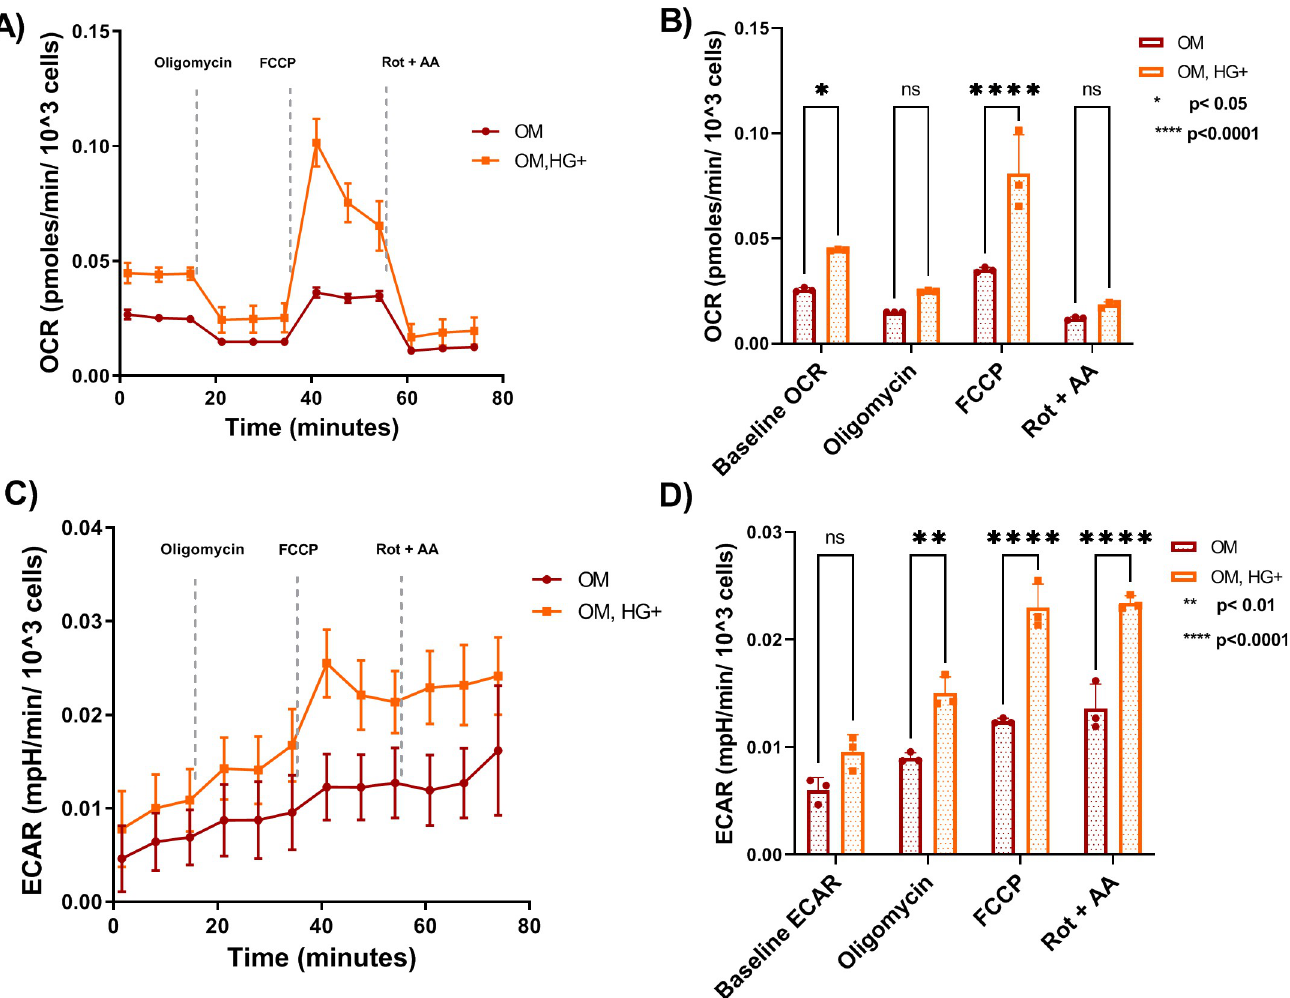
Fig 4. HG-induced osteoblast cells utilize both mitochondrial respiration and Glycolysis more efficiently than healthy cells. A. Oxygen consumption rate is indicative of mitochondrial respiration in healthy and HG-treated cells. B. Four channels of sequential injections exhibited an increase in OCR levels in HG-treated bone cells. C. Extracellular acidification rate is indicative of glycolysis in healthy and HG-treated cells. D. Four channels of sequential injections exhibited an increased in ECAR levels in HG-treated bone cells. Abbreviations: OCR = Oxygen Consumption Rate; ECAR = Extracellular Acidification rate. Error bars indicate SD (standard deviation). Data were analyzed using Two-way ANOVA. A total of N = 3 independent experiments per culture condition were performed. All experiments were performed in triplicates.